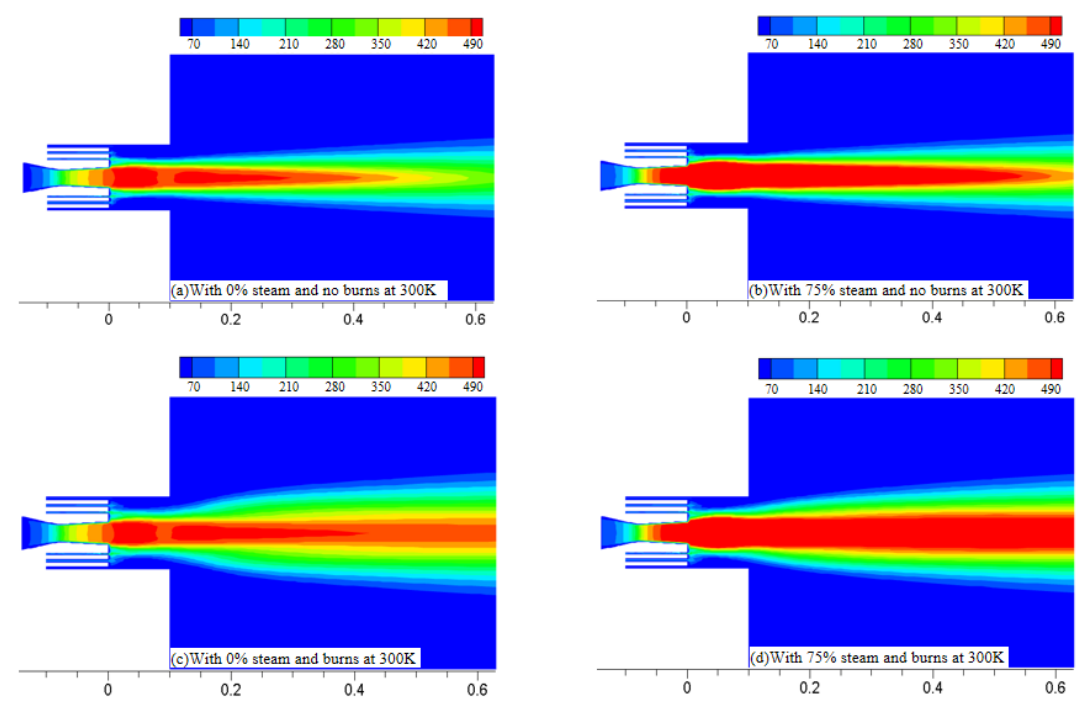
Figure 7. Enlarged view of the axial velocity nephogram on the centerline of the coherent supersonic jet.